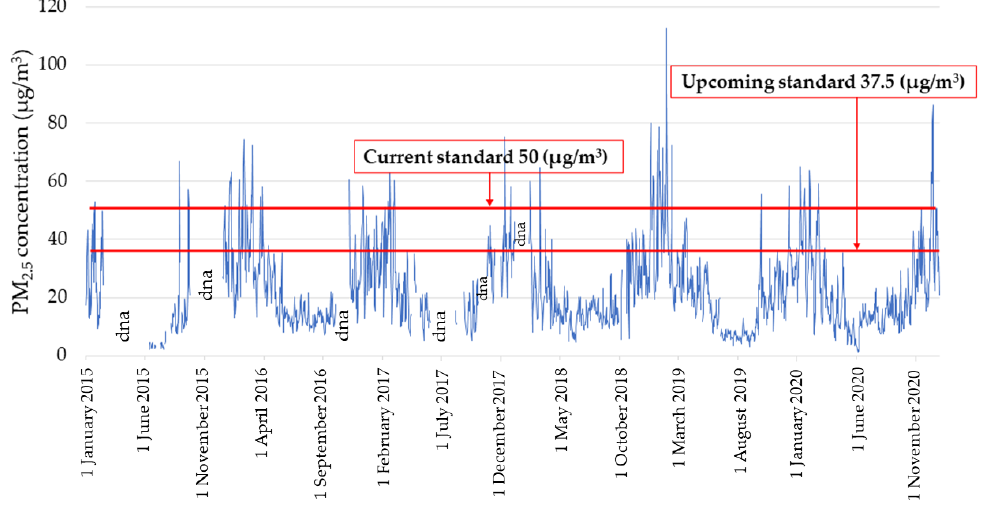
Figure 3. Daily averages (over 24 h) of PM 2.5 concentrations from 2015 to 2020 obtained at Kasetsart University using TEOM. Some days are missing data due to equipment maintenance.